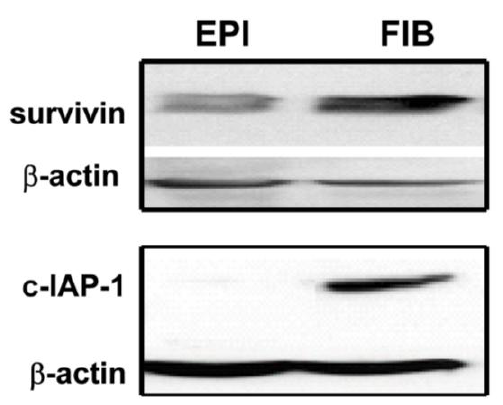
FIGURE 5. Survival and antiapoptosis expression in EPI and FIB cells. FIB cells expressed increased survivin and c-IAP-1 proteins at higher levels than EPI